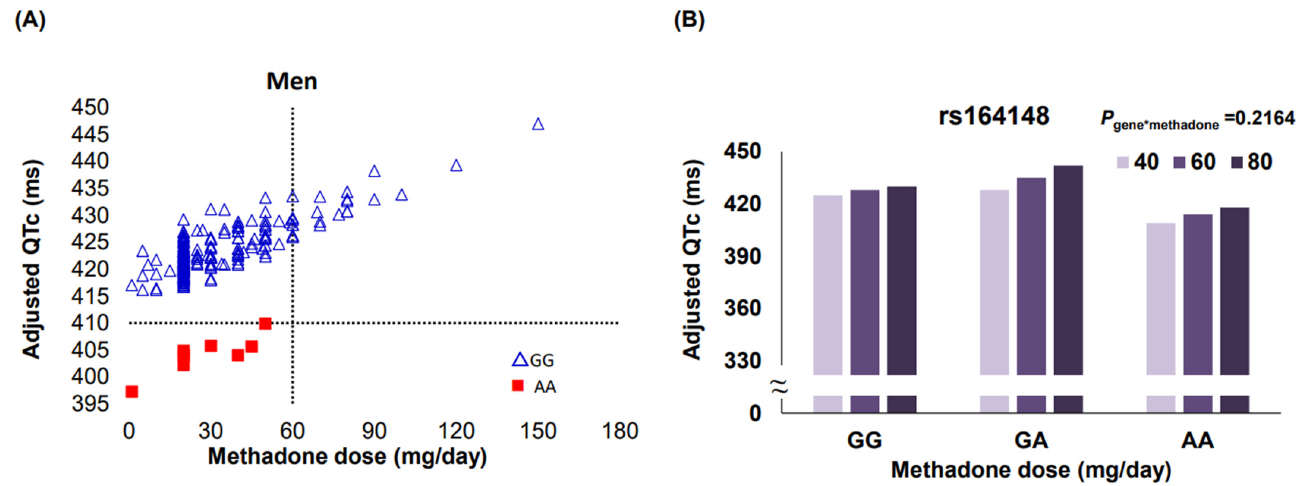
Figure 2. Association of NOS1AP rs164148 AA genotype with QTc intervals and analysis of NOS1AP - methadone interaction in men on methadone. ( A ) A cut-off adjusted QTc interval of ≤ 410 ms identified 100% of rs164148 AA carriers compared to none of the rs164148 GG carriers when receiving methadone at 30.6 ± 19.3 mg/day in male patients. ( B ) The PROC GLM model was used to explore the interaction between the rs164148 NOS1AP variant and methadone dose in relation to the adjusted QTc intervals during maintenance methadone treatment in male participants, the corresponding QTc interval from each genotype carriers taking a projected methadone dose of 40 mg/day, 60 mg/day, and 80 mg/day. There was no significant gene-drug interaction in contributing to the adjusted QTc intervals (P gene*methadone = 0.216) in carriers of the rs164148 AA genotype when compared to that observed for